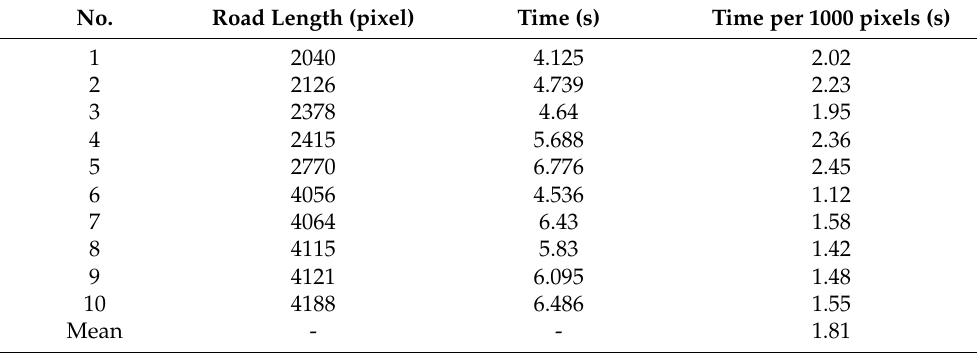
Table 2. Evaluation table of road extraction